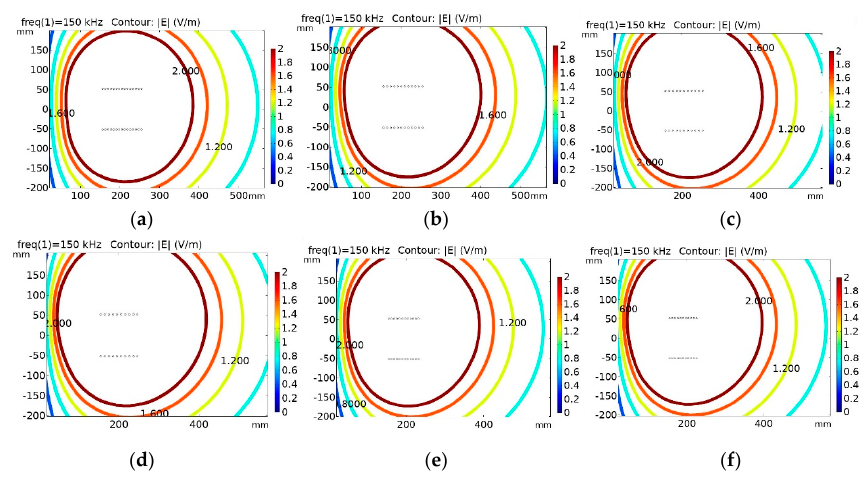
Figure 7. When the inner diameter is 311 mm, the power transmission efficiency η and EMF distribution which are from the WPT system without shielding coils changes with the turn of power transmission coils ( N p ) and the distance between adjacent turns ( d ). ( a ) N p = 15, d = 7 mm, η = 97.07% and the mutual inductance M = 45.06 μ H. ( b ) N p = 12, d = 8.91 mm, η = 95.74% and M = 28.86 μ H. ( c ) N p = 11, d = 9.8 mm, η = 94.76% and M = 24.24 μ H; ( d ) N p = 10, d = 10.09 mm, η = 93.24% and M = 20.04 μ H; ( e ) N p = 12, d = 7 mm, η = 94.94% and M = 26.71 μ H; ( f ) N p = 11, d = 7 mm, η = 93.47% and M = 21.83 μ H.